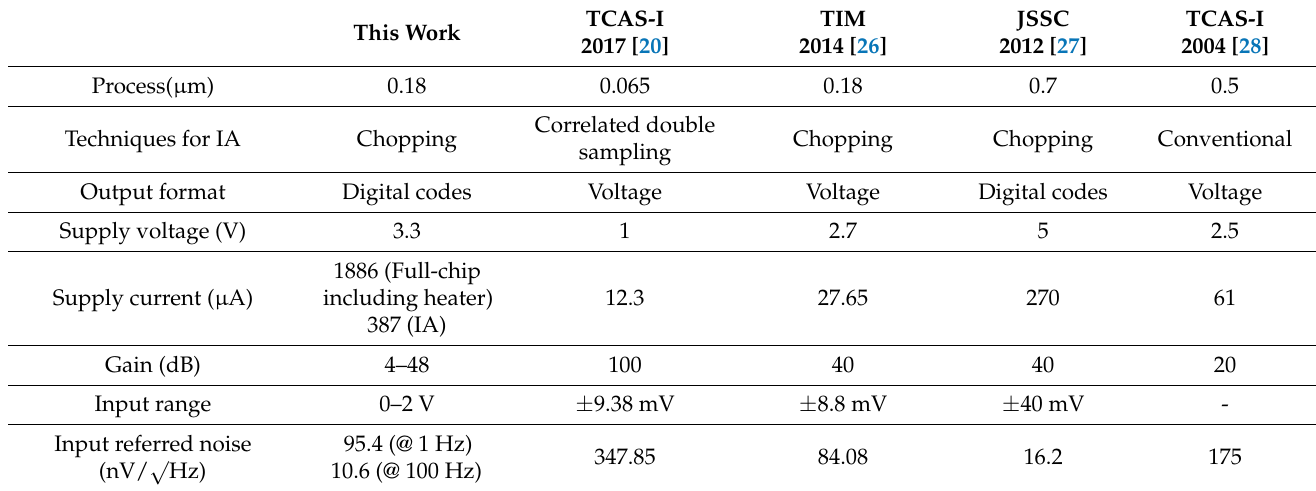
Table 1. Performance summary between the proposed readout IC and previous studies.